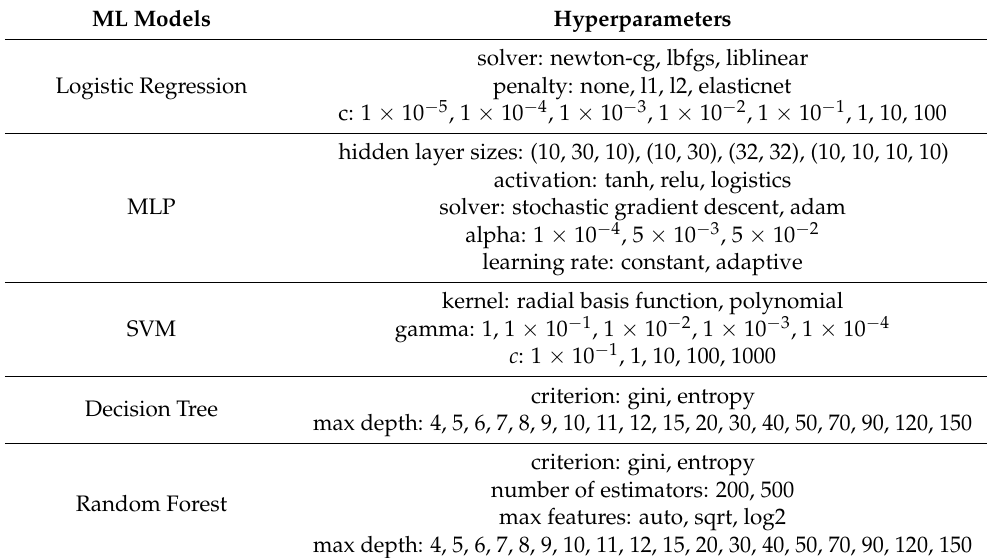
Table 1. List of the considered ML models and the different hyperparameters during the grid search. Hyperparameters define the complexity of the ML and each model’s learning performance during the training.